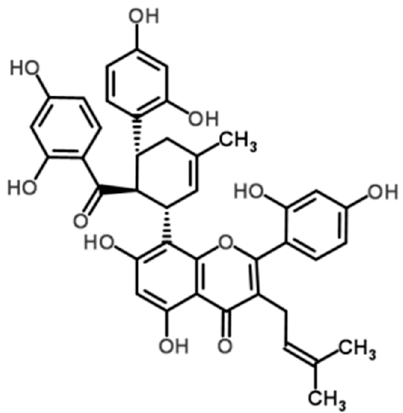
Figure 1. Chemical structure of Kuwanon G (KWG).